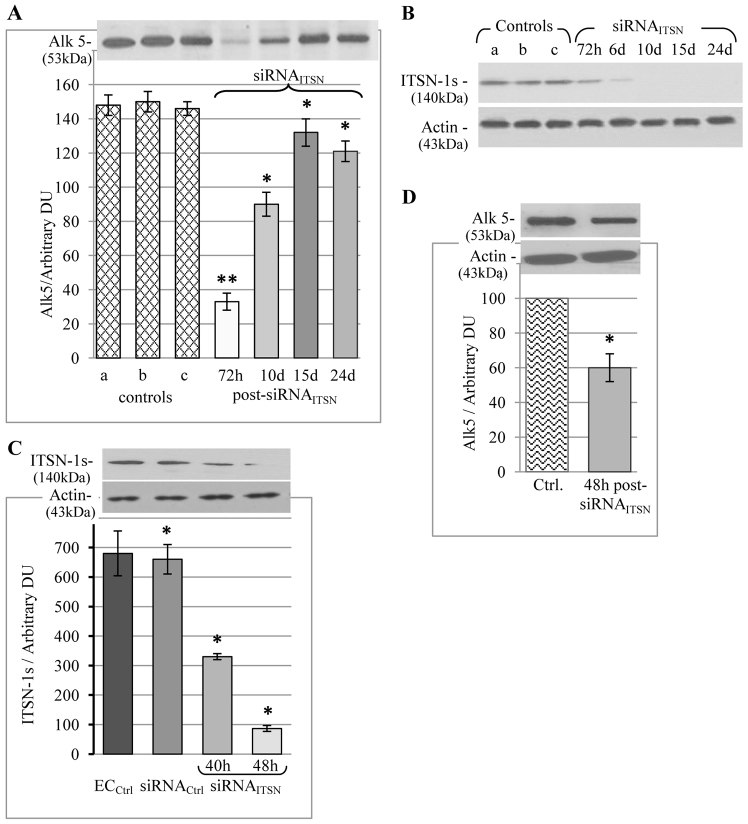

KD-ITSN mouse lungs and ECKD-ITSN show decreased Alk5 protein expression.KD-ITSN mouse lungs and ECKD-ITSN show decreased Alk5 protein expression. (A) Western blot of Alk5 from lung lysates (70 µg total protein) of wild-type mice (a), empty-liposome- (b) and siRNACtrl-treated (c) mice, as well as lung lysates from KD-ITSN mice at different time points post siRNA treatment, as indicated. Values are shown as the mean±s.e.m. *P<0.01; **P<0.05 versus controls. (B) Lung lysates (70 µg/lane) of the same controls as shown in panel A and siRNAITSN-treated mice were analyzed by western blotting with antibodies against ITSN-1 and actin (as the loading control), at several time points post delivery; n = 3 mice for each experimental condition and time point considered. (C) Cell lysates (50 µg of total protein) of non-transfected cells (ECCtrl), endothelial cells transfected with the siRNACtrl and endothelial cells transfected with siRNAITSN were analyzed by SDS-PAGE and immunoblotting with anti-ITSN primary antibody. Actin served as the loading control. Values are shown as the mean±s.e.m. *P<0.01 versus ECCtrl. (D) Cultured ECCtrl and ECKD-ITSN, 38–40 h post siRNAITSN transfection, were subjected to SDS-PAGE, electrotransfer to nitrocellulose and western blotting for Alk5 protein expression; actin served as the loading control. DU, densitometric units. Values are shown as the mean±s.e.m. *P<0.01 versus ECCtrl. All data are representative of least three independent experiments.